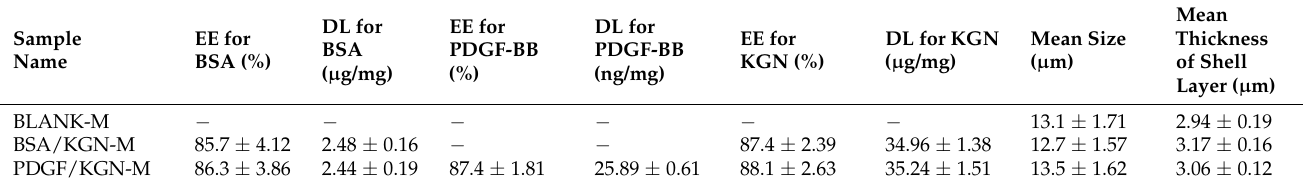
Table 1. Parameters for three kinds of core-shell